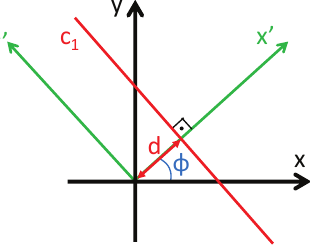
Figure 1. Line parametrization through the distance to the origin d and the angle between the normal line and the x axis, φ